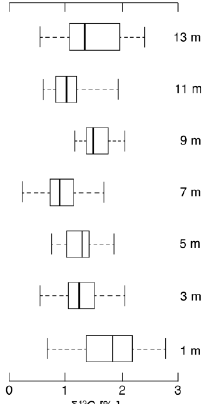
Figure 2. Circumferential δ 13 C variability at 1 m height. Colored curves represent radii A–F.